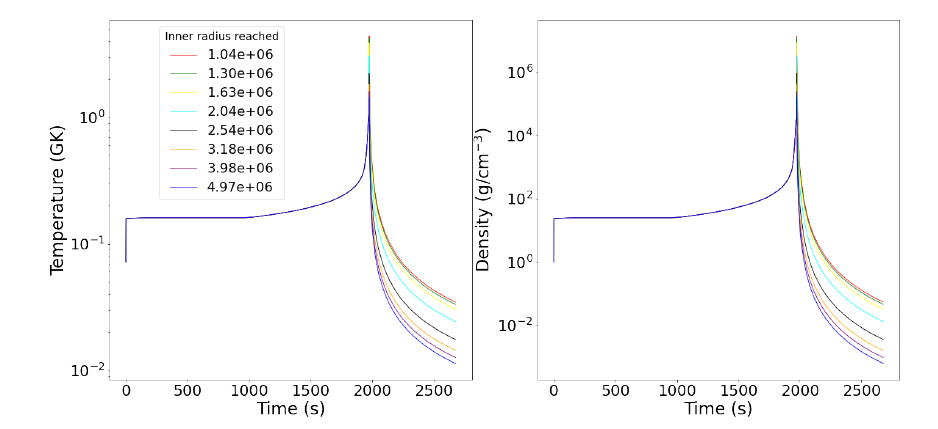
Figure 2. Left: Temperature-time plot for trajectories. Right: Density-time plot for trajectories. Mate- rial in trajectories is accreting around a 1 . 5M ⊙ neutron star at an accretion rate of 8 × 10 − 5 M ⊙ s − 1 . Unit of inner radius is